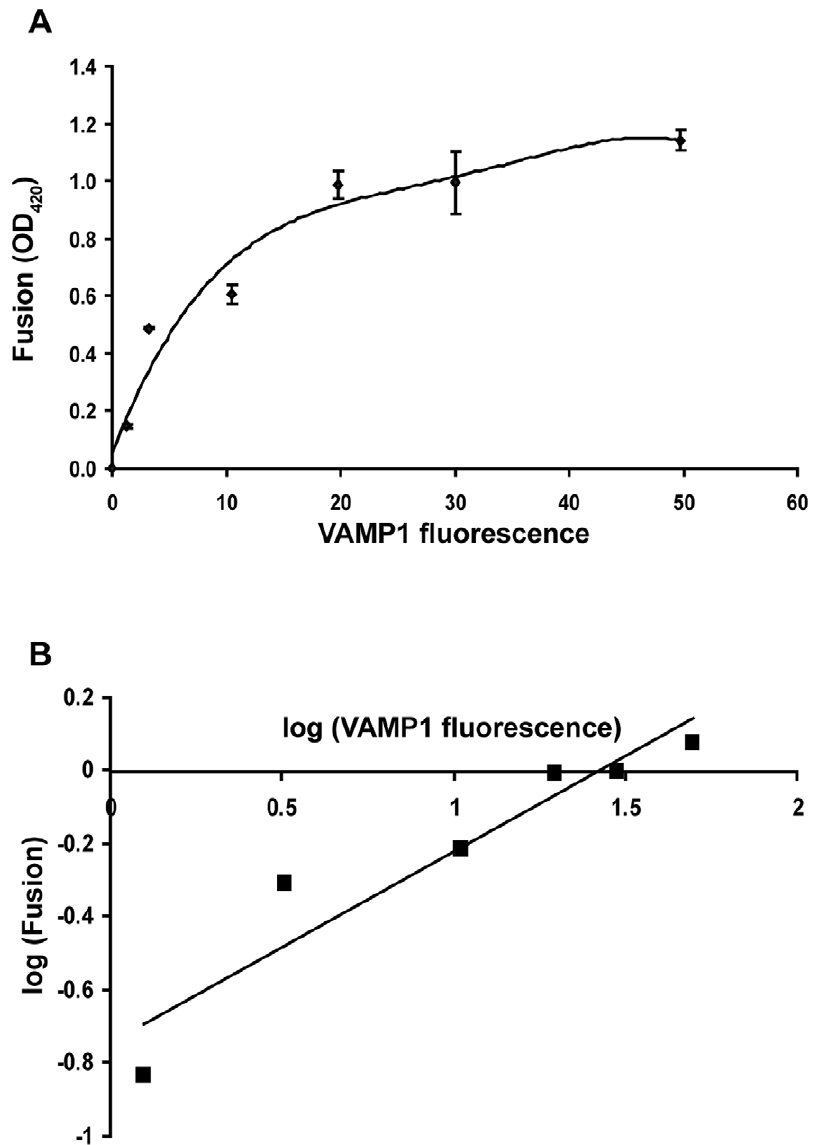
Figure 7. Dependence of cell fusion activity on cell surface density of VAMP1. (A) v-cells were cotransfected with tTA (1 m g per 10 cm 2 growth area) and increasing amount of the flipped VAMP1 plasmid (per 10 cm 2 growth area): 0.01, 0.02, 0.05, 0.1, 0.2 and 0.5 m g. After the v-cells were combined with the t-cells expressing syntaxin1/SNAP-25 for 24 h, cell fusion was quantified. In parallel experiments, the expression level of VAMP1 proteins at surface of the v-cells was determined by staining with the anti-Myc antibody and FACS analysis. A polynomial regression curve was generated to model the relationship between cell fusion activity (OD 420 ) and mean fluorescence intensity of VAMP1 staining. Error bars represent standard deviation of three independent experiments. (B) Log-log plot of cell fusion activity vs. mean fluorescence intensity of VAMP1 staining. The solid line shows a linear regression, which yields a slope of 0.52 with a correlation coefficient of 0.901.